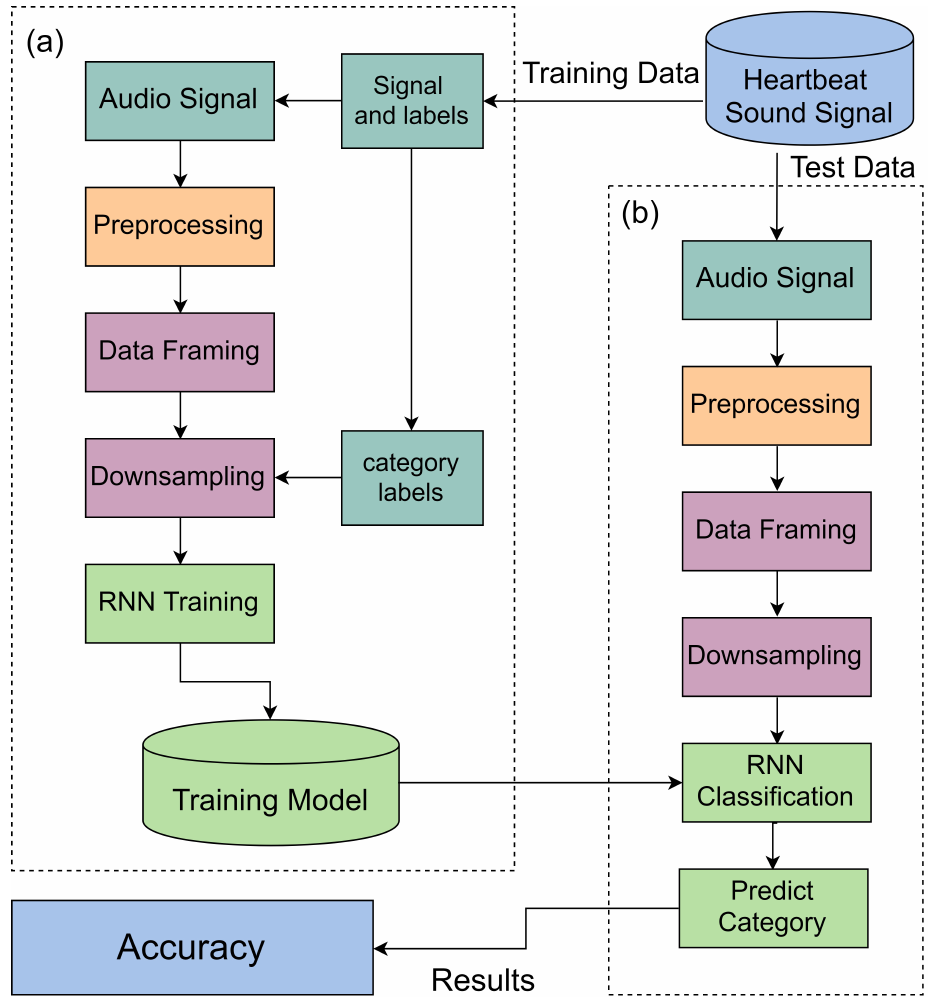
Figure 2. The main Framework of Heartbeat sound Classification, ( a ) is the training phase and ( b ) is the test phase.